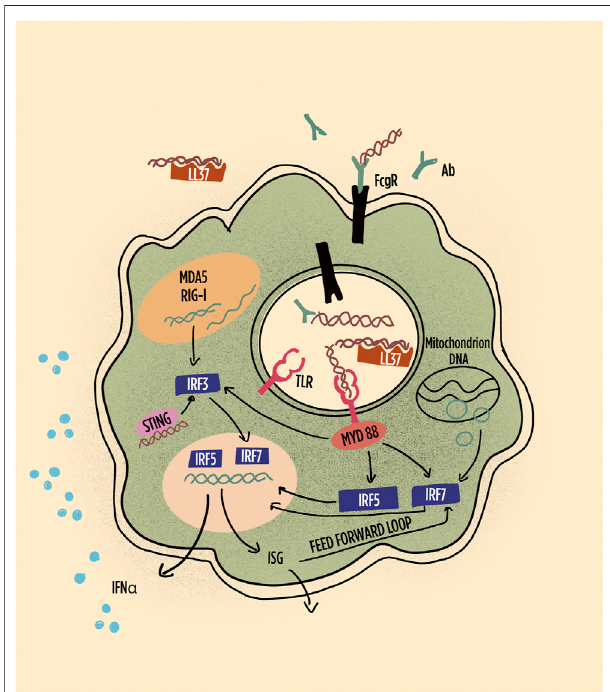
FIGURE 3 | Schematic representation of pathways leading to interferon (IFN) production and IFN responses in plasmacytoid dendritic cells (pDCs). Highlighted are the role of immune complexes and LL-37 in shuttling DNA/ RNA into endosomes; the subsequent the role of TLR in inducing interferon regulatory factors and their role in gene transcription of IFN-alpha and other interferon-induced gene products, including feed-forward loops. RNA,particularlylongdouble-strandedRNA,ispreferentiallysensedbyMDA5 and RIG1. Abbreviations: Ab: antibody; FcgR: Fc gamma receptor; IRF: interferon regulatory factor; LL-37: cathelicidin-37; MDA5: melanoma differentiation – associated protein 5; MyD88: myeloid differentiation primary response 88; RIG-1: retinoic acid inducible gene-1; STING: stimulator of interferon genes; TLR: toll-like receptor.